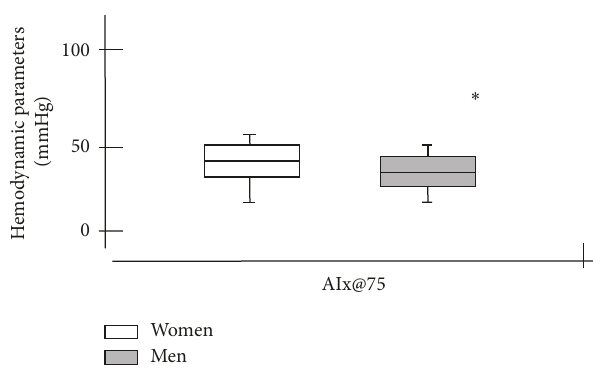
Figure 2: Comparison of heart rate-corrected augmentation indices between women and men. AIx@75 = heart rate-corrected augmen- tation index. ∗ Comparison of blood pressure parameters between women and men ( 𝑃 < 0.05